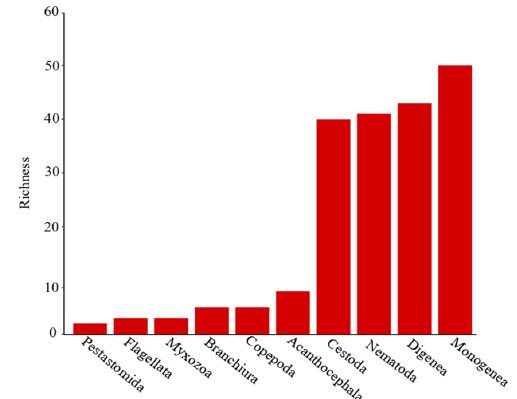
Figure 4. Richness of parasite groups registered in the hosts of the upper Paraná River floodplain in 37 years.